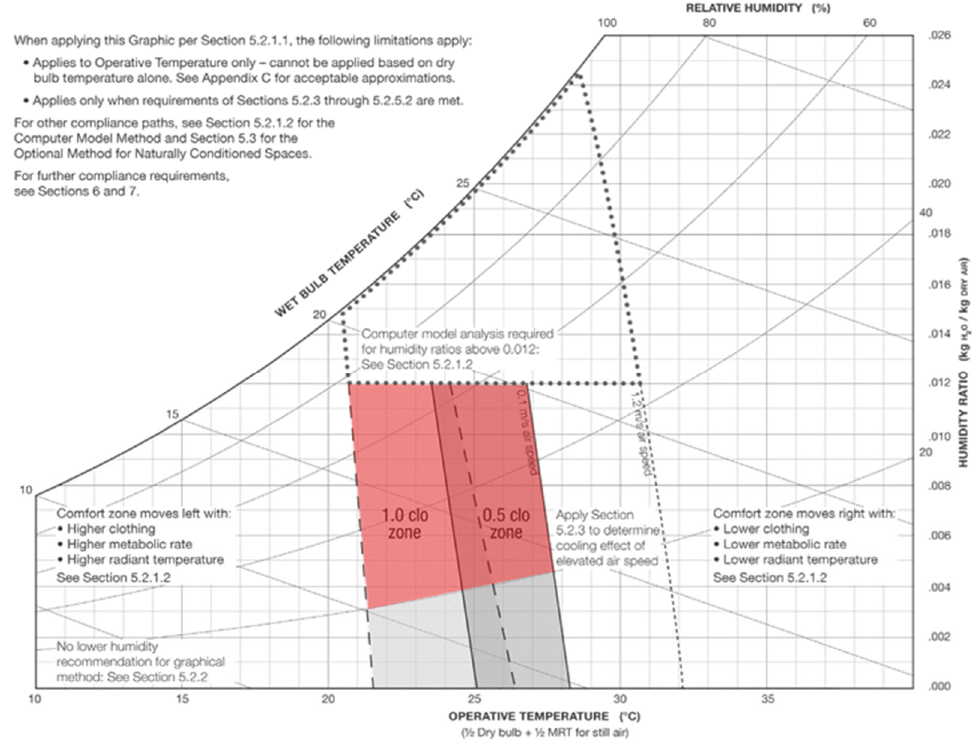
Figure 13. Modified American Society of Heating, Refrigerating, and Air-Conditioning Engineers (ASHRAE) thermal comfort chart.